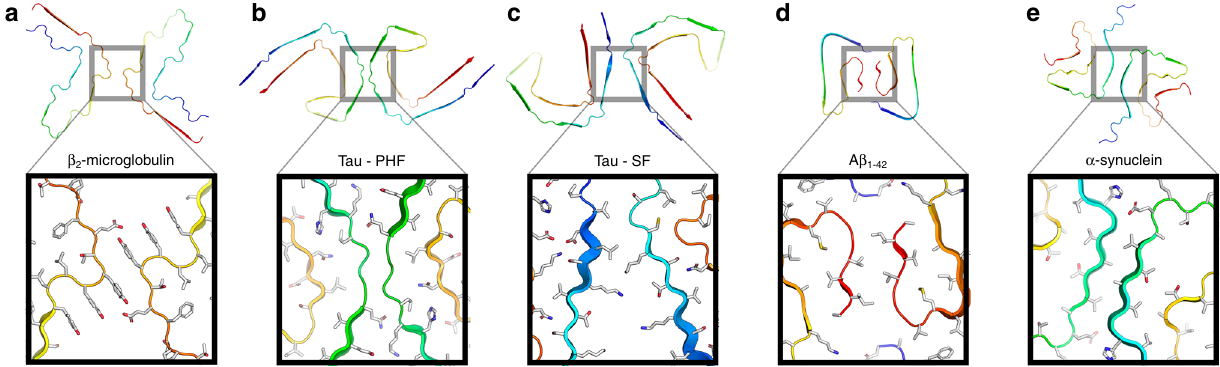
Fig. 7 Inter-proto fi lament interactions in cryo-EM structures of amyloid fi brils. Comparisons of the subunit structures (upper) and interfaces between proto fi laments (boxes) of a β 2 m, Tau variants 11 that form b paired helical fi laments (PHF) and c straight fi laments (SF), d A β 1 – 42 10 and e α -synuclein 13 . The β -strands present in each structure are coloured blue. Fibrils were analysed from the following PDB fi les: Tau PHF (5o3l), Tau SF (5o3t), A β α